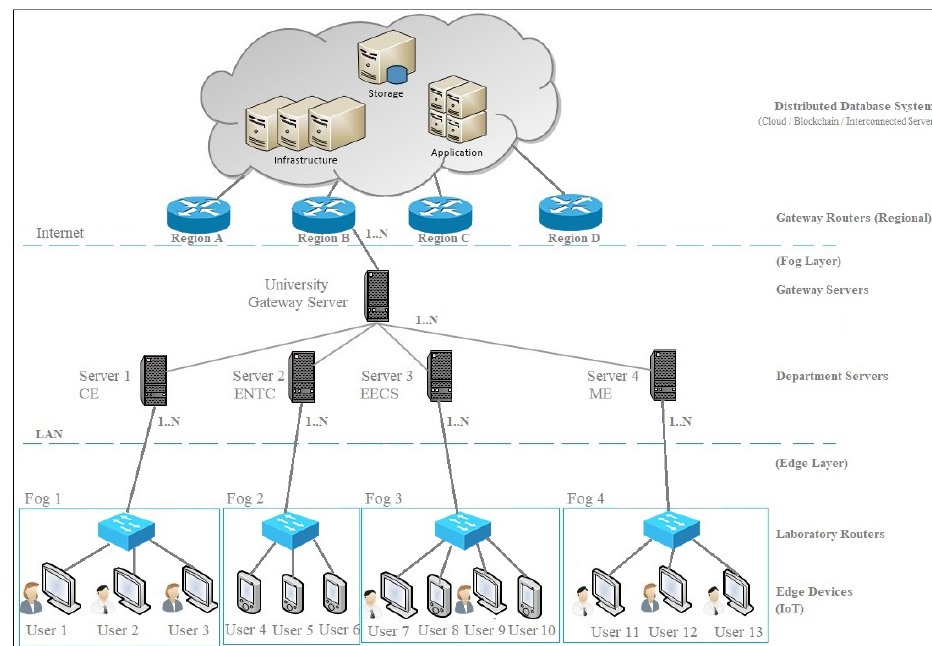
Figure 1. Fog/edge architecture for the university